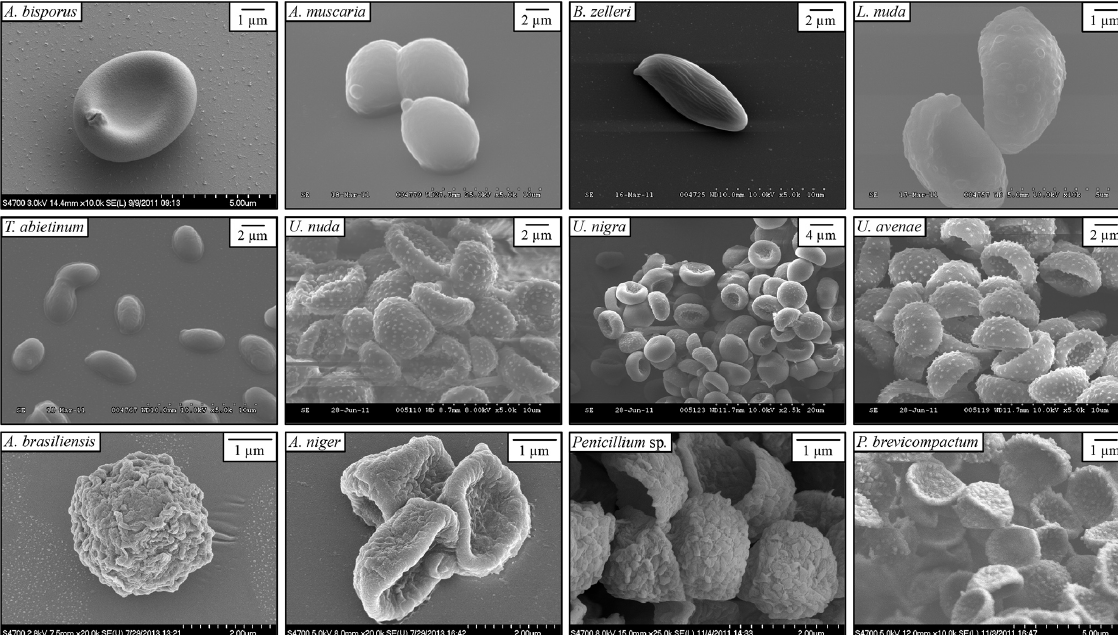
Figure 1. SEM images of spores from the classes Agaricomycetes ( A. bisporus , A. muscaria , B. zelleri , L. nuda , and T. abietinum ), Ustilagi- nomycetes ( U. nuda , U. nigra , and U. avenae ), and Eurotiomycetes ( A. brasiliensis , A. niger , Penicillium sp., and P. brevicompactum ).